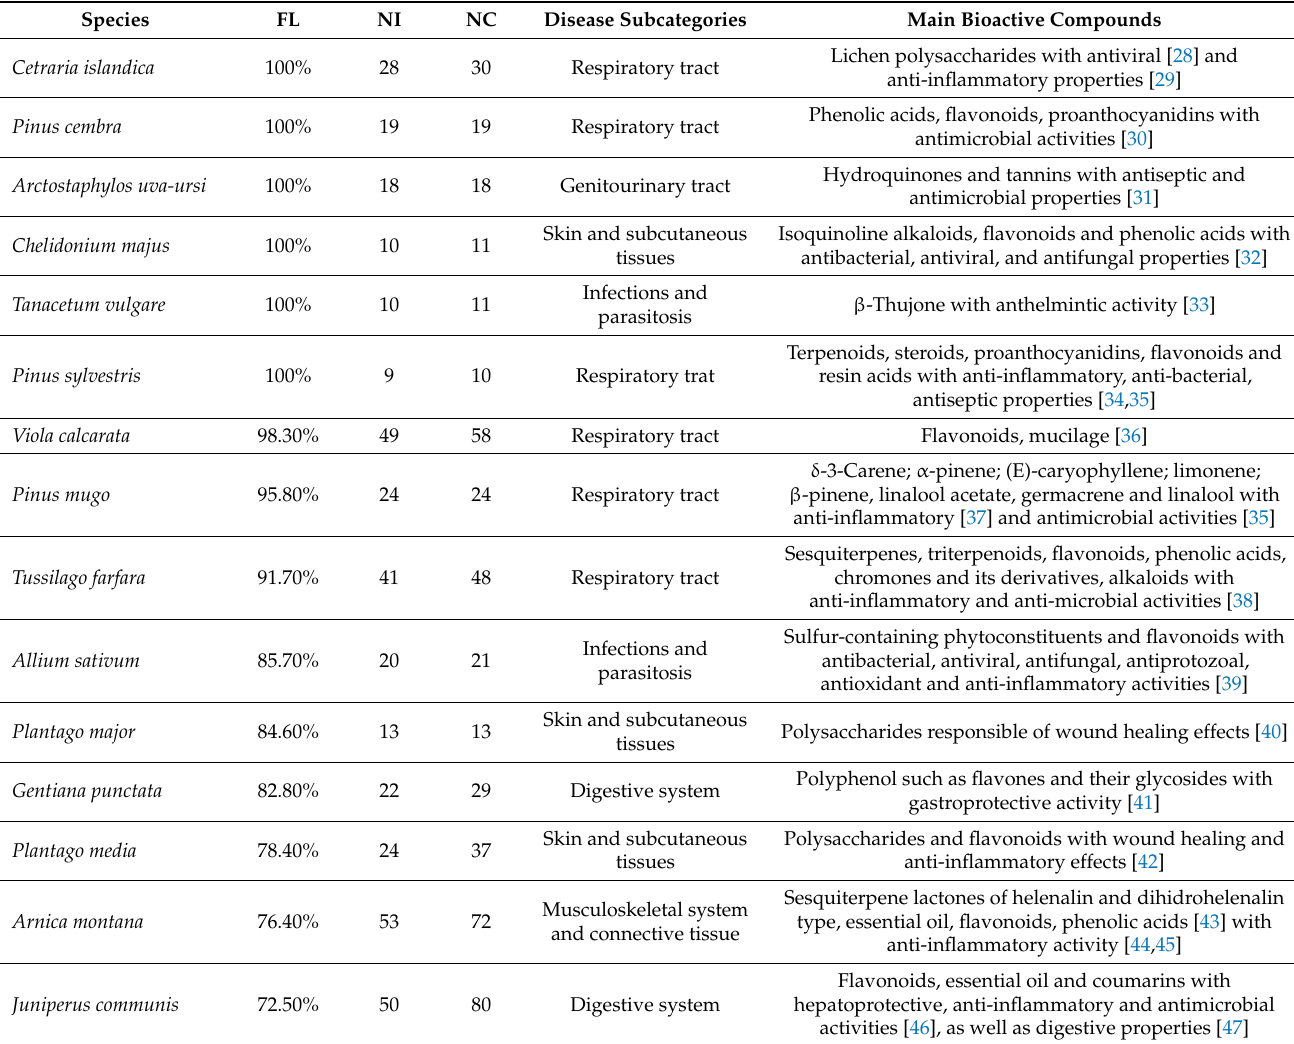
Table 5. Fidelity level (FL) value of medicinal plants against a given disease subcategory and main bioactive compounds responsible for the therapeutic